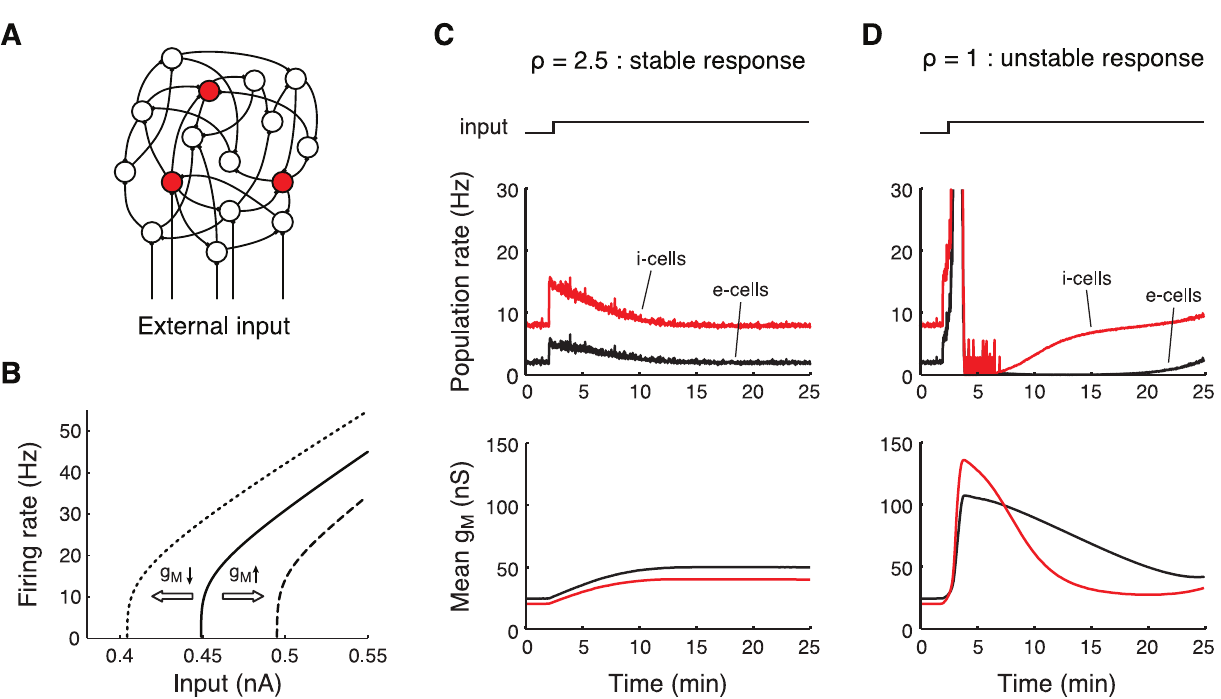
Figure 1. Stable and unstable dynamics of a recurrent network showing HSE. A: Schematic of the network model with e-cells (white circles) and i-cells (red circles) receiving input via recurrent network connections and via excitatory projections from outside the network. B: HSE mechanism operates by shifting the neural response function. The firing rate of an e-cell receiving DC current input is shown (solid line). An increase of the membrane conductance g M leads to a rightward shift of the response function (dashed line), making the cell less excitable. Decreasing g M results in a leftward shift of the response function (dotted line), increasing the cell’s excitability. C–D: Response of a recurrent network with HSE to a persistent increase in the external drive (top trace) by 50%. In C the i-cells adapt 2.5 times more slowly than the e-cells ( r ~ 2 : 5 ). In D both cell types adapt on the same time scale ( r ~ 1 ). Top panels show the population mean of the instantaneous firing rates of the e-cells (black) and i-cells (red), computed for 1 second bins. Bottom panels show population mean of g M of the e-cells (black) and i-cells (red). The compound external drive to e-cells and i- cells before the input increase is 1.2 kHz.